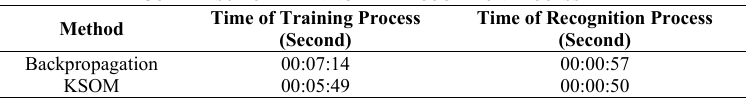
TABLE 6 C OMPARISON OF T RAINING AND R ECOGNITION P ROCESS T